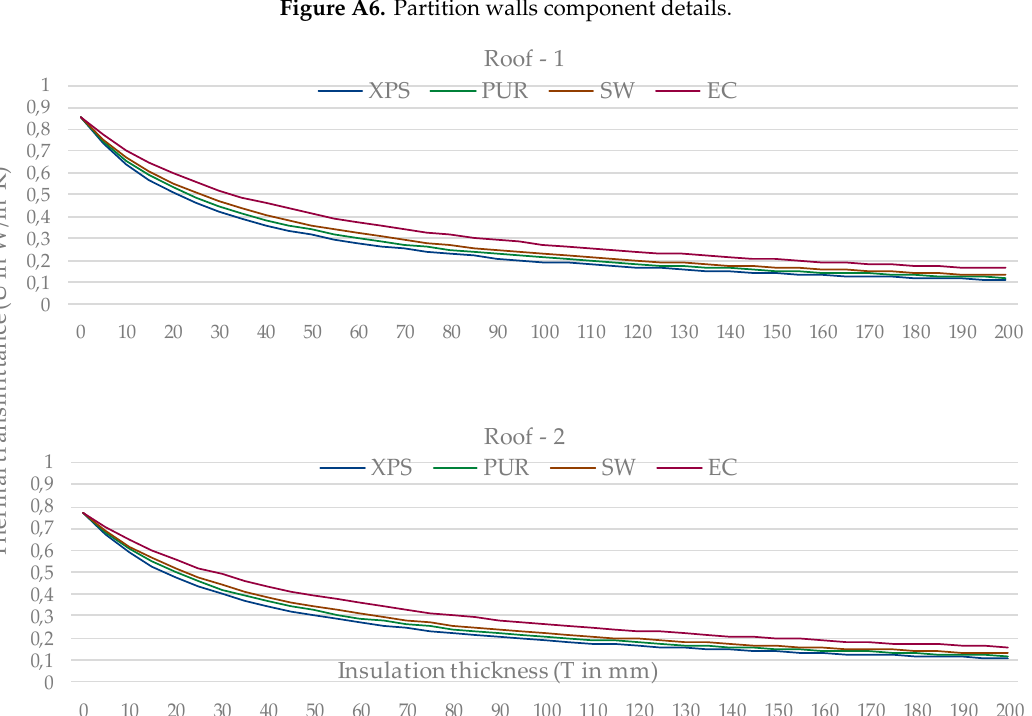
Figure A7. Thermal transmittance (U-value) according to insulation thickness, for roofs.